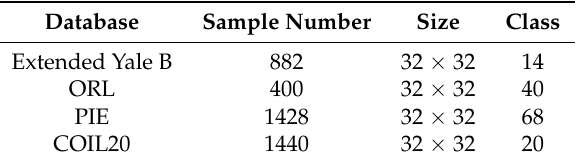
Table 1. The detailed information about used